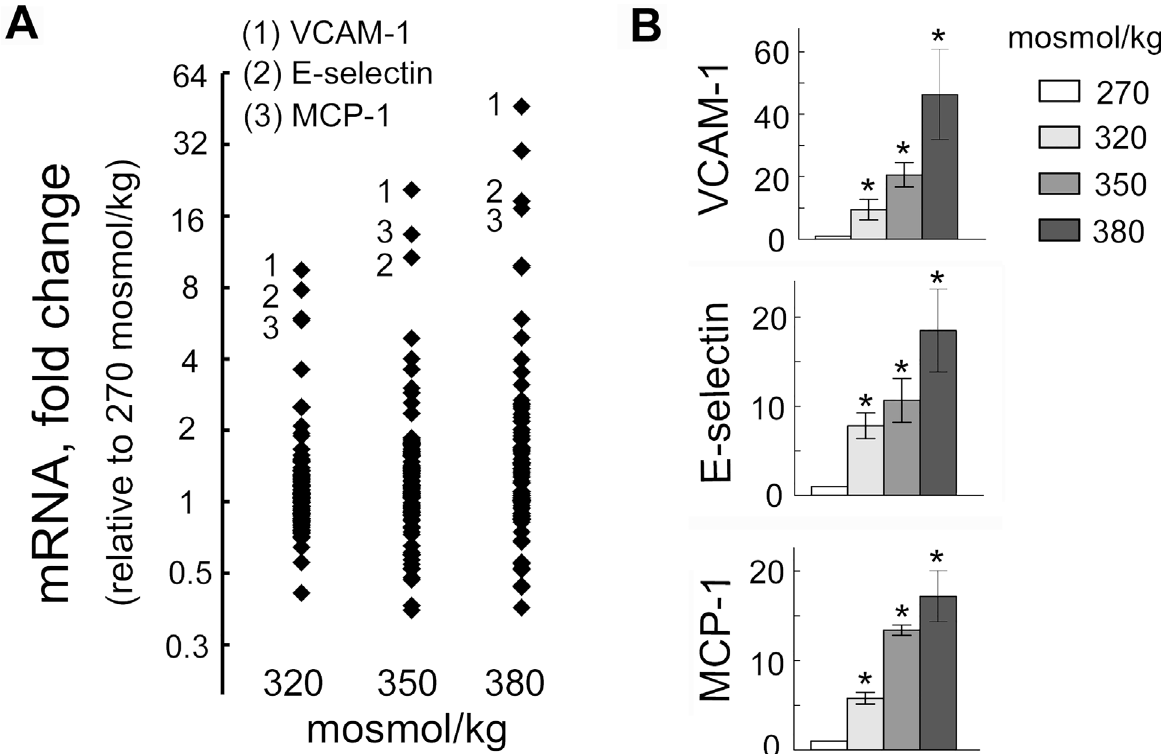
Fig 1. Elevation of extracellular NaCl increases expression of pro-inflammatory mediators in endothelial cells. HUVECs were exposed to media in which NaCl was elevated for 4 days from 270 mosmol/kg to the total osmolality indicated in the figure panels. mRNA for 84 genes was measured by real-time PCR as described in Methods. (A) mRNA of adhesion molecules VCAM-1, E-selectin and of chemokine MCP-1 showed biggest increase upon exposure to high NaCl. The graph plots fold changes relative to 270 mosmol/kg of mRNA for 84 genes related to endothelial cell biology. Each dot shows mean value from 3 independent experiments. (B) Statistical analysis for VCAM-1, E-selectin and MCP-1 (mean ± SEM, * P < 0.05, N = 3)